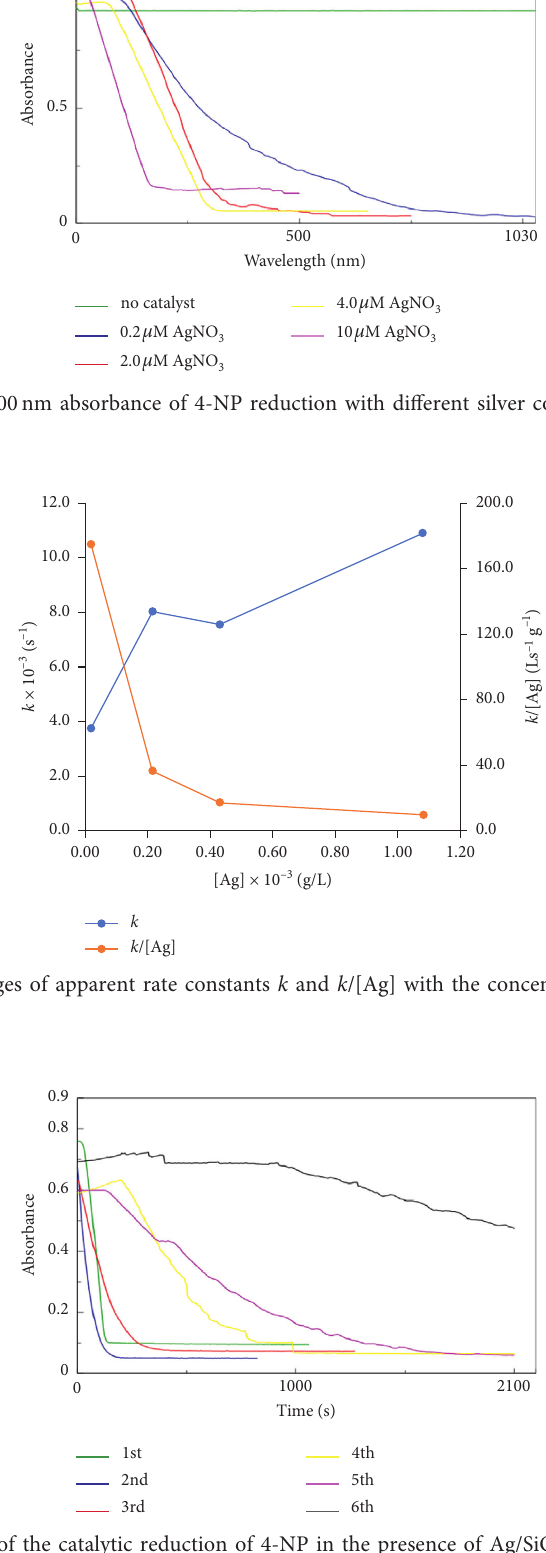
2 after repeated